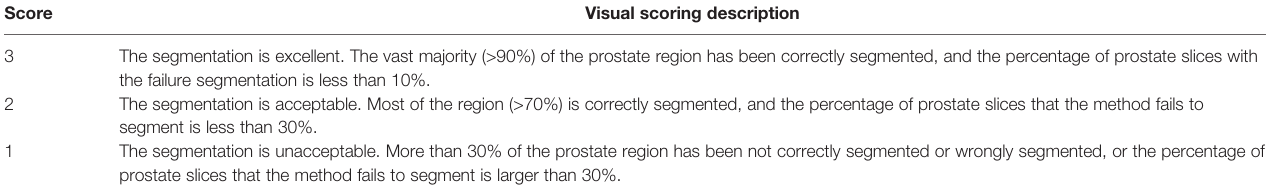
TABLE 3 | Description of each visual grade for qualitative segmentation